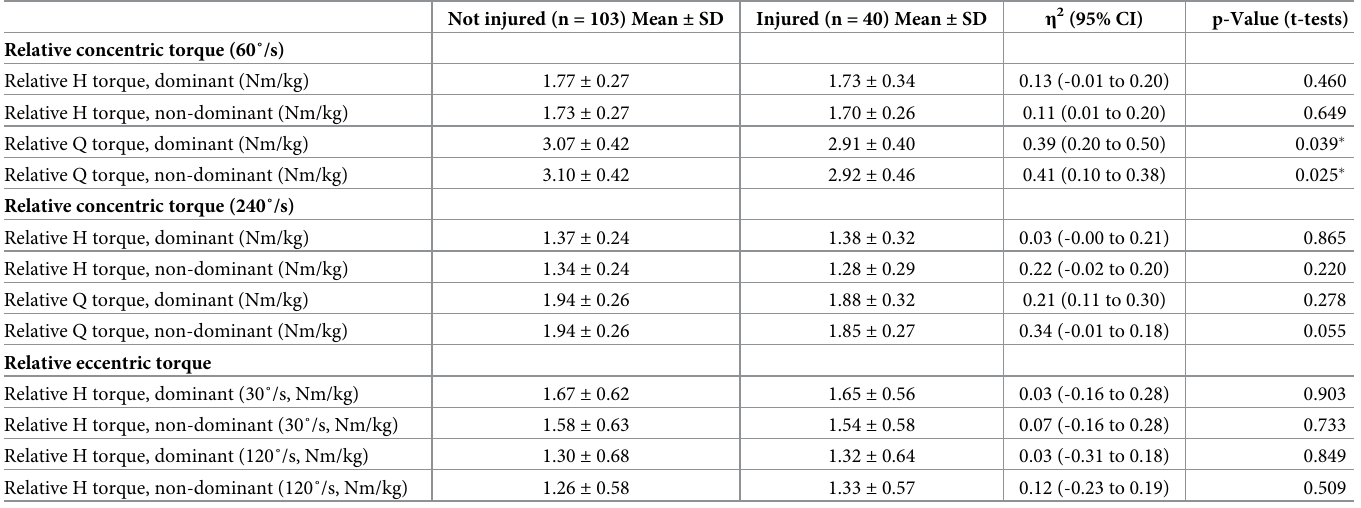
Table 4. Isokinetic values relative to body